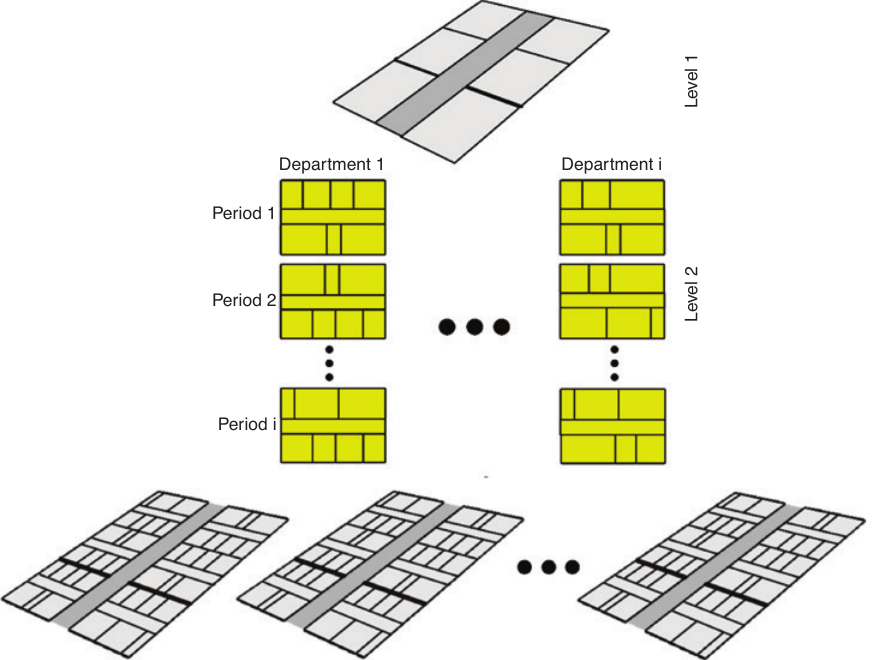
Figure 3: Three-Level Adaptive FLP